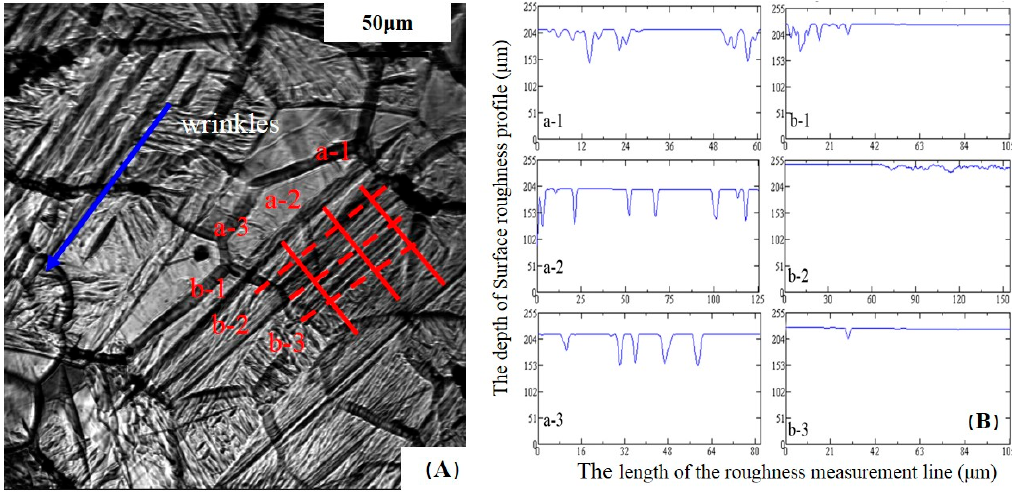
Figure 3. ( A ) the direction of the different measuring line; ( B ) the surface roughness value of different measuring line.